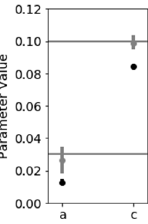
Figure 9. Inference of parameters a and c by ( A ) taking into account the entire dPAT recording, ( B ) discarding dPAT samples corresponding to cuff pressures greater than P dia .